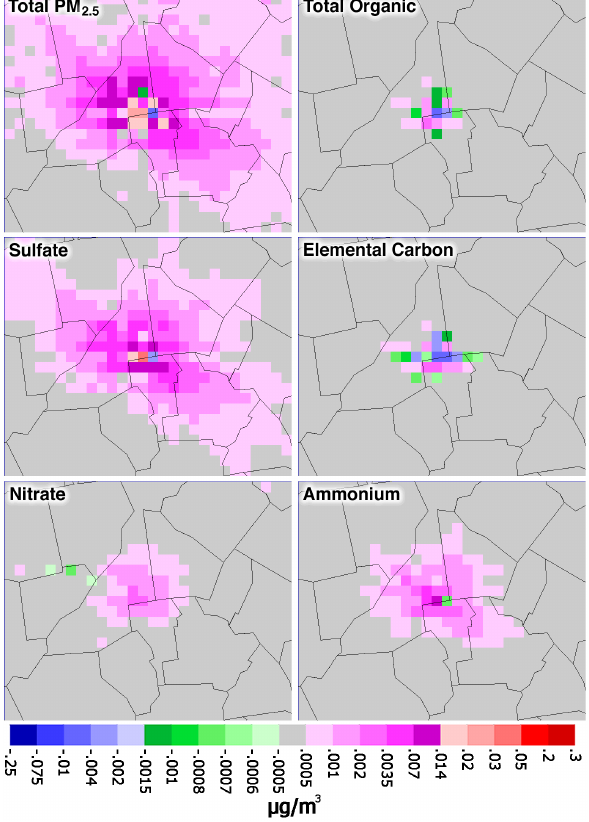
Fig. 3. Aircraft impact on average surface concentrations of PM 2 . 5 and five component species in June and July 2002 (i.e., base case TC1 minus no-aircraft case TC2).